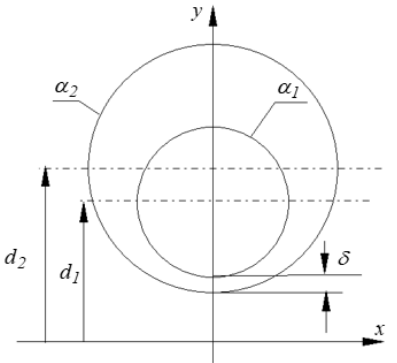
Figure 4. Geometrical characteristics of an eccentric ring.